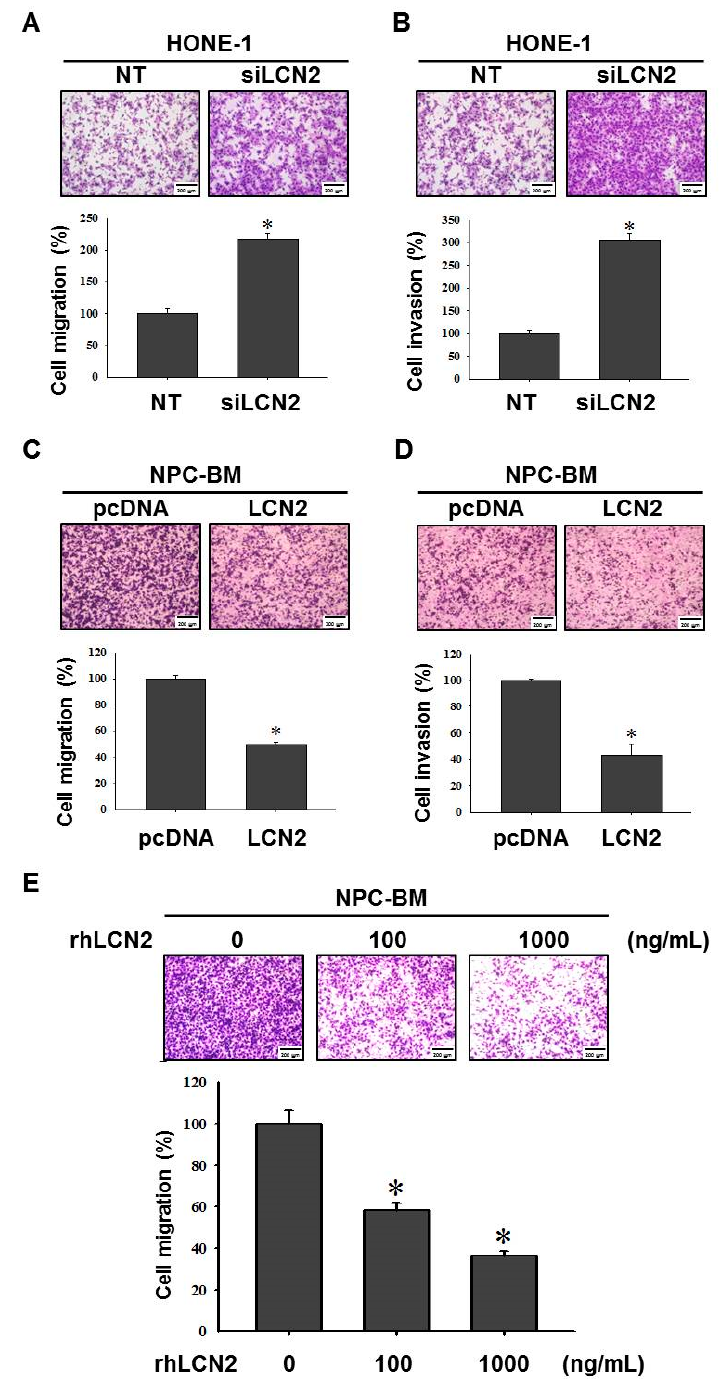
Figure 2. LCN2 negatively regulated cell migration and invasion of human NPC cells. The HONE-1 cells were transfected with siRNA against LCN2 (siLCN2) or control (NT). After siRNA transfection, the HONE-1 cells were examined in terms of cell migration ( A ) and cell invasion ( B ). The NPC-BM cells were transfected with control plasmids (pcDNA) or plasmids containing LCN2 (LCN2). After plasmids transfection, the NPC-BM cells were examined in terms of cell migration ( C ) and cell invasion ( D ). ( E ) NPC-BM cells were treated with recombinant human LCN2 (rhLCN2, 0–1000 ng/mL) and then examined in terms of their cell migration ability. * p < 0.05 compared with control.